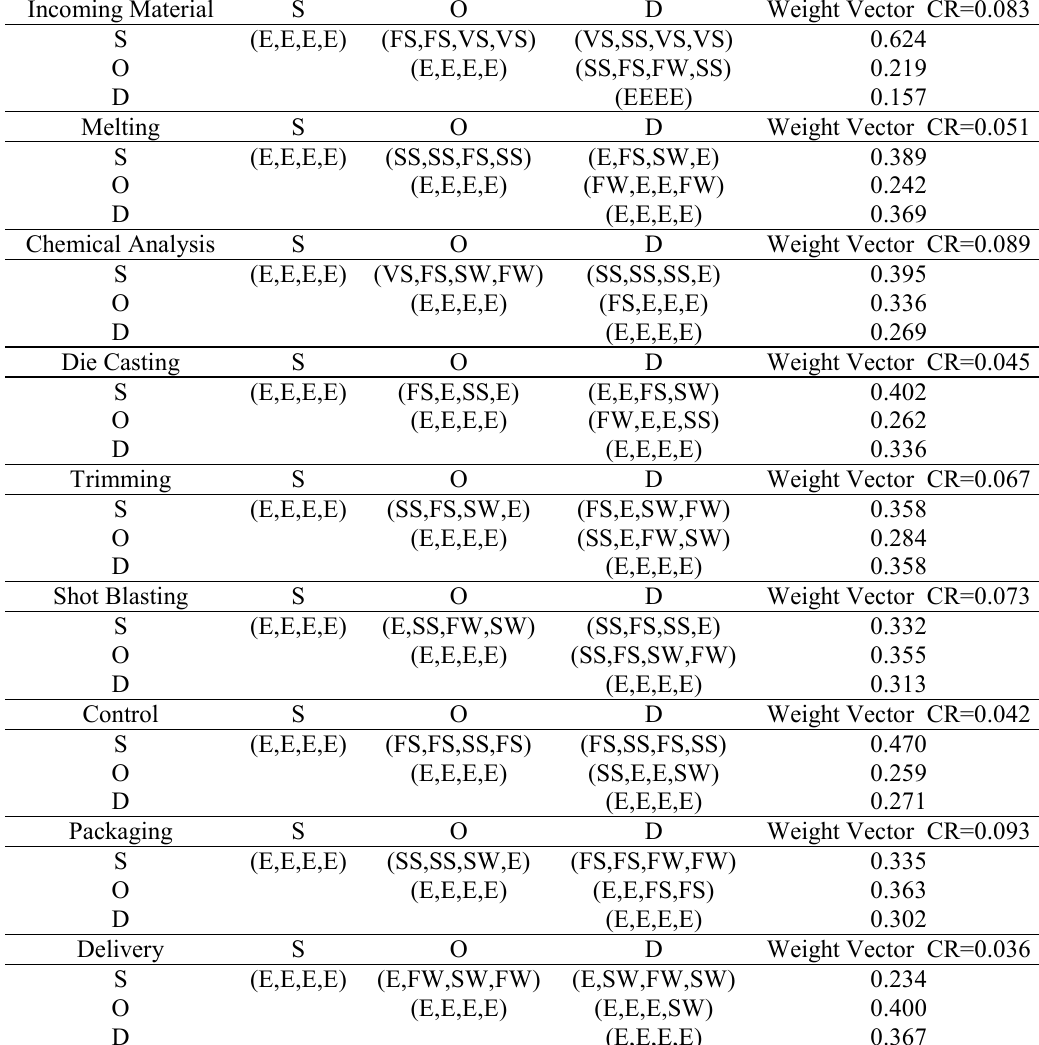
Table 4. The pair-wise evaluations of experts in linguistic variables for S, O and D risk factors for each process function Incoming